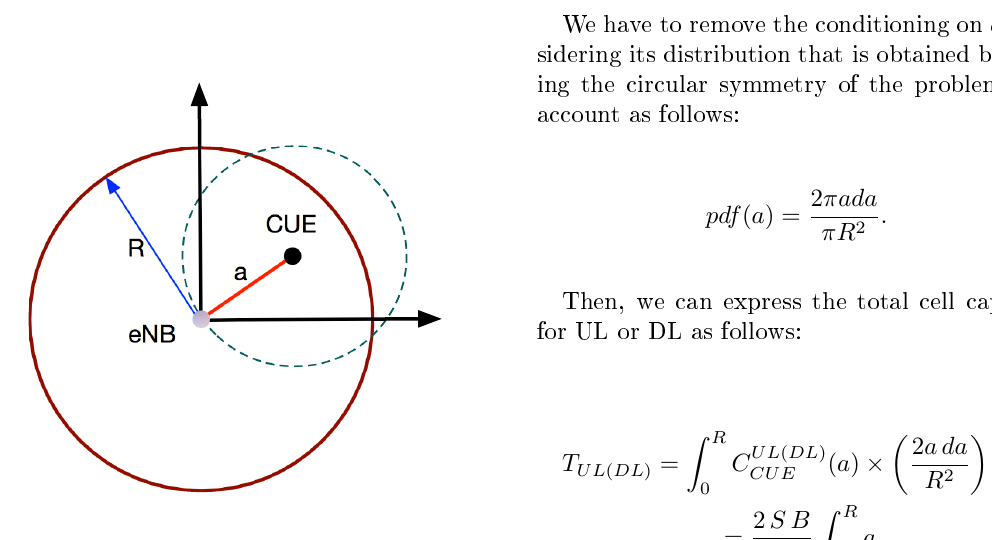
Fig. 2: CUE capacity model for circular